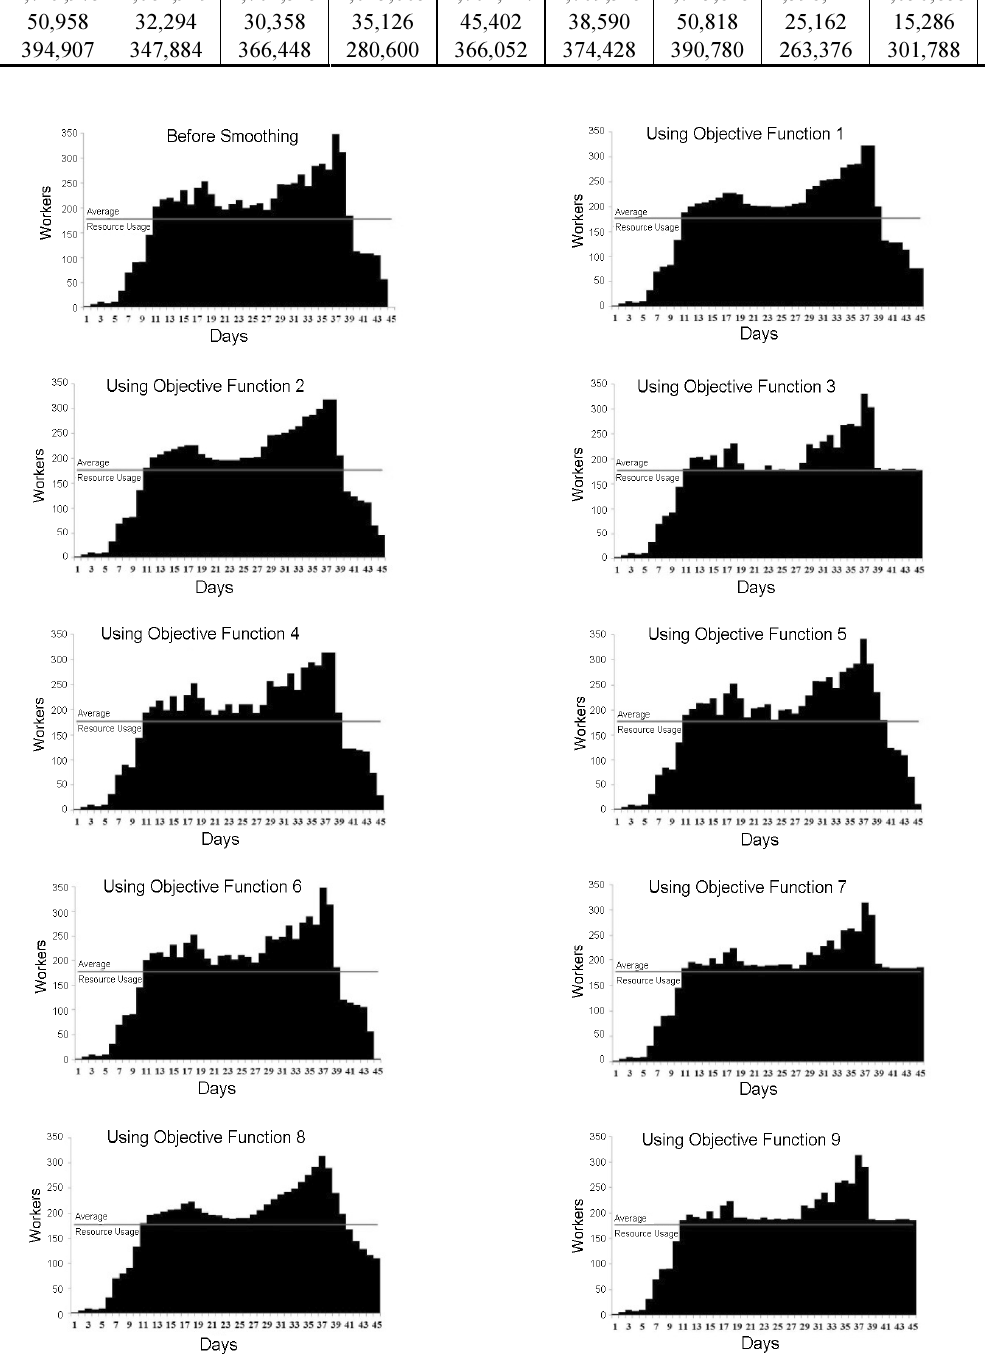
Fig. 6. Resource histogram before and after resource